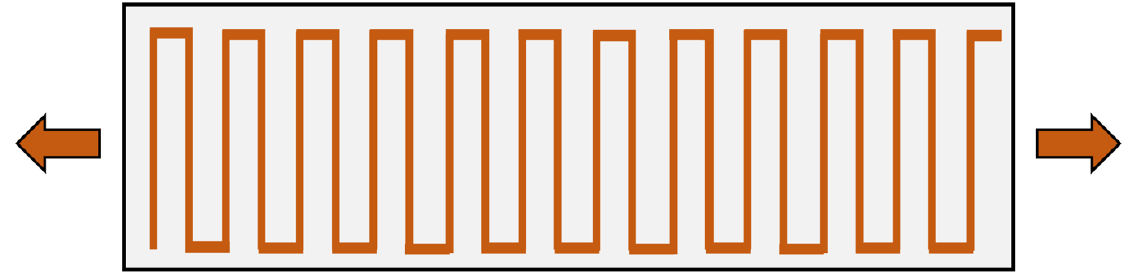
Figure 2. LW-DED Raster 90 toolpath.